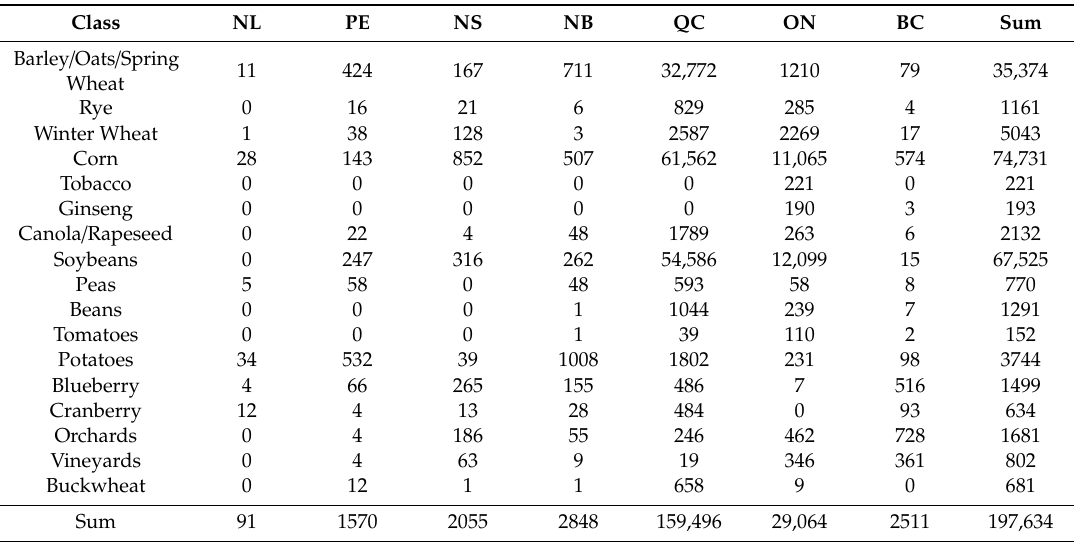
Table 1. The list of cropland classes along with their number of field samples (polygons) which were used in this